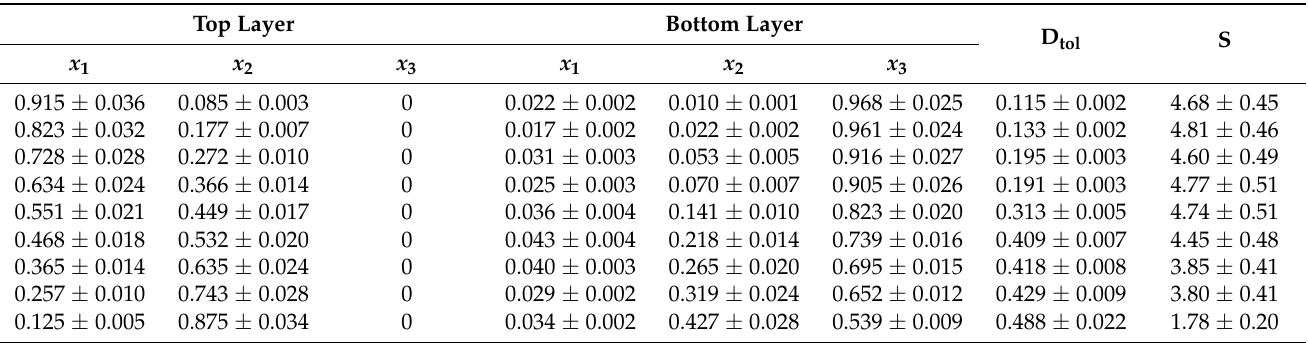
Table 7. Composition of the experimental tie-lines (mole fraction), the toluene distribution ratio (D) and selectivity (S) for the ternary system {1-hexene (1) + toluene (2) + DES #2 (3)} at 298.15 K and 101.325 kPa a .